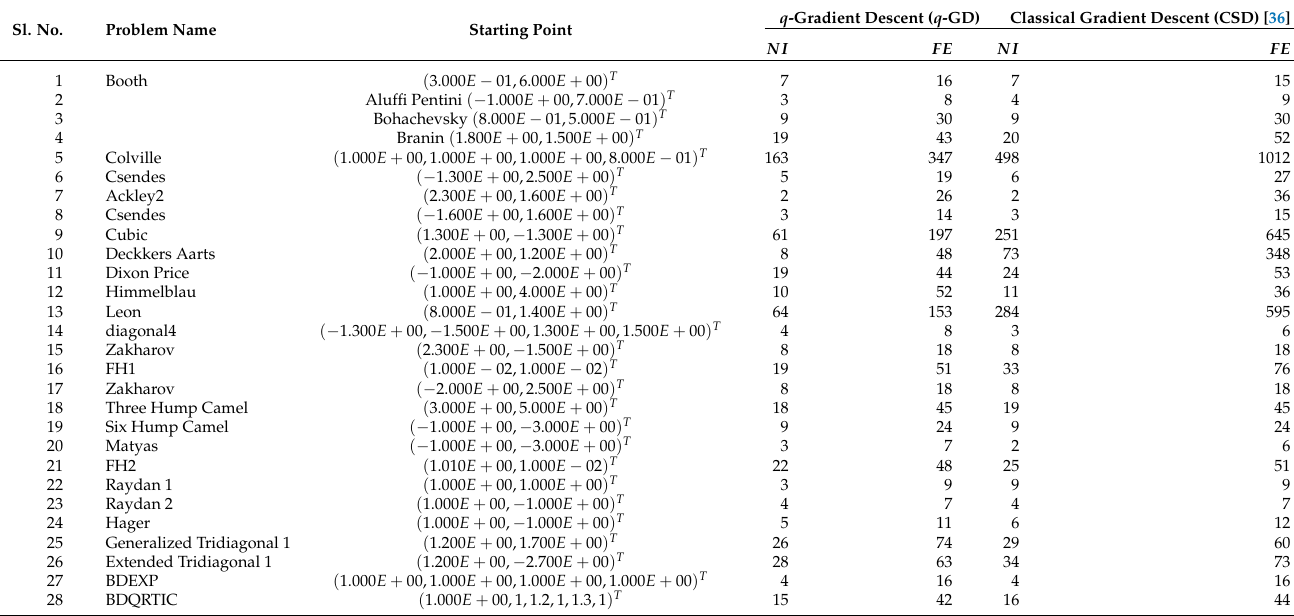
Table 4. Numerical results of 28 test